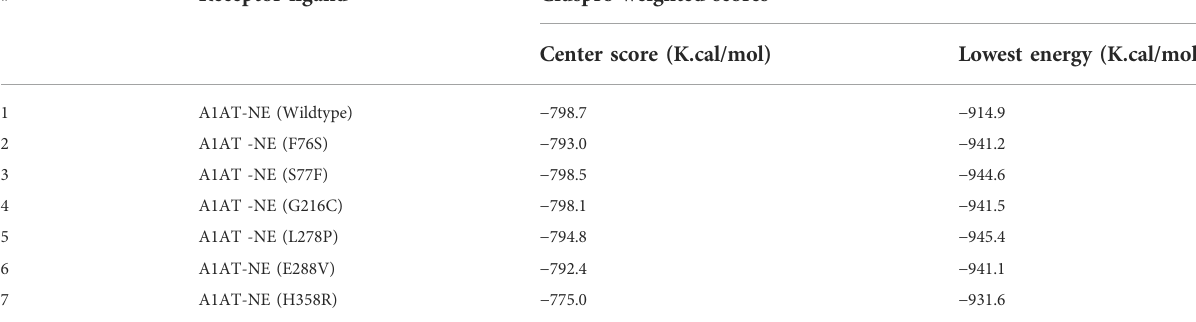
TABLE 5 Cluspro predictions of A1AT-NE molecular complex binding energy scores. # Receptor-ligand Cluspro weighted scores Center score (K.cal/mol) Lowest energy